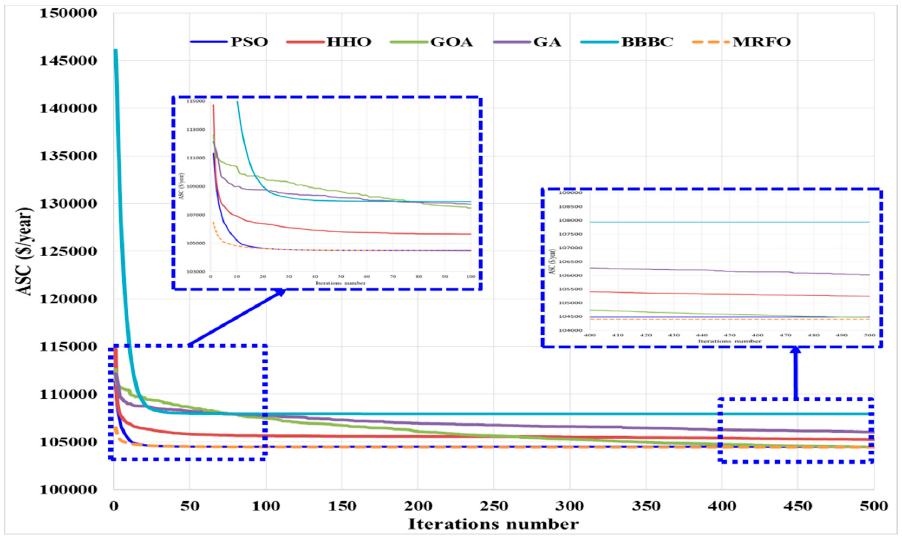
Figure 9. Convergence rate of the MRFO in comparison with the other five intelligent algorithms.